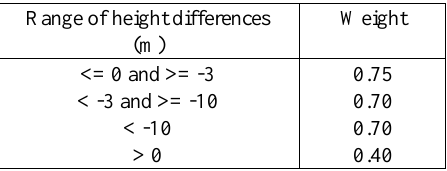
Table 1. Weighting based on height